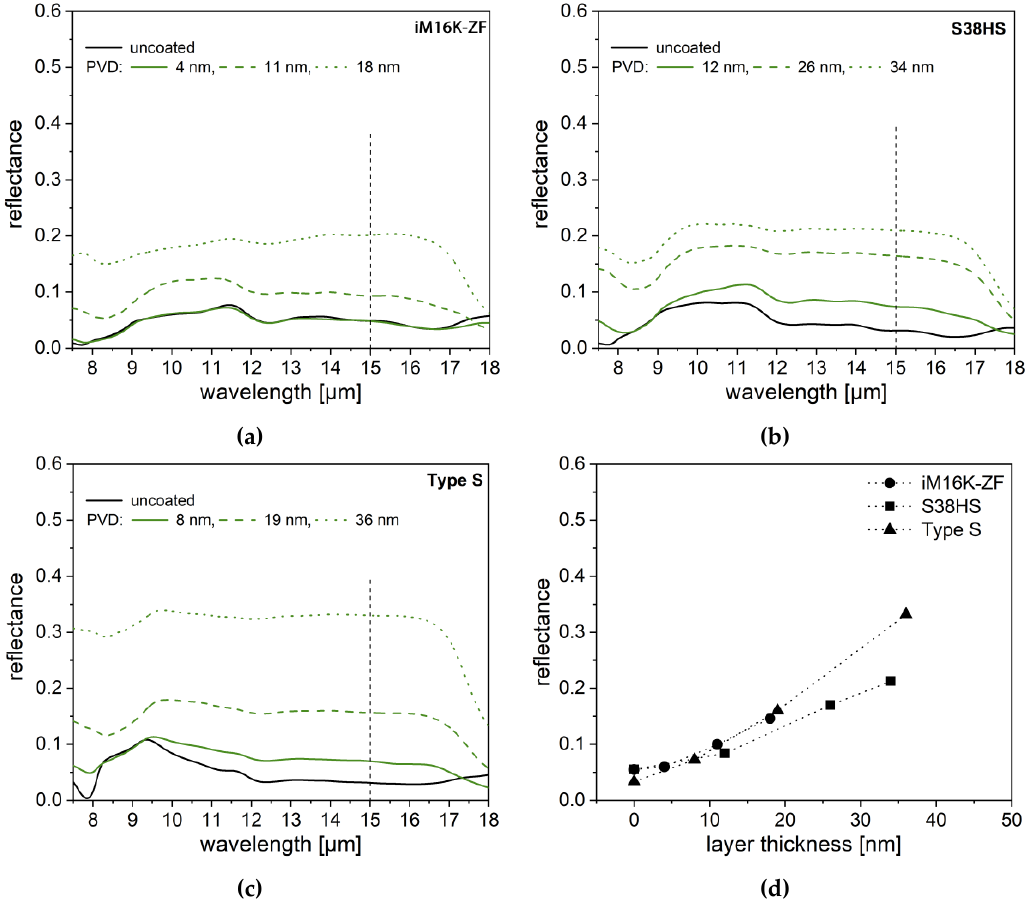
Figure 14. Results of the reflection measurements of the PVD-coated MGS (reference spheres, ( a ): iM16K-ZF, ( b ): S38HS, ( c ): Type S) as well as the reflection at a wavelength of 15 µm of each sphere types plotted over the layer thickness ( d ). An increased reflection with increasing layer thickness can be